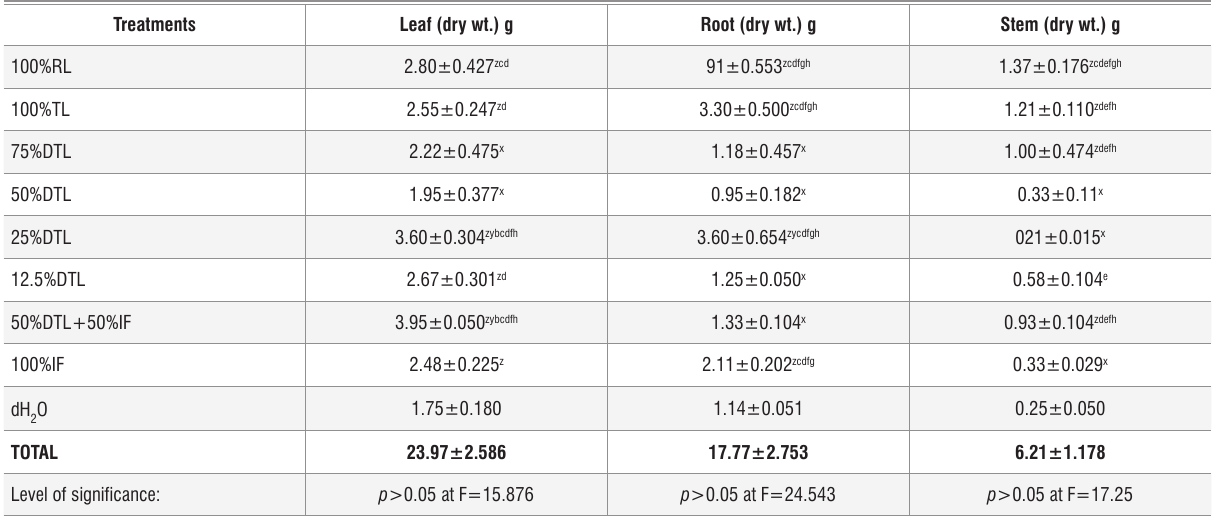
Dry leaf, root and stem weights of Brassica rapa L. after 56 days